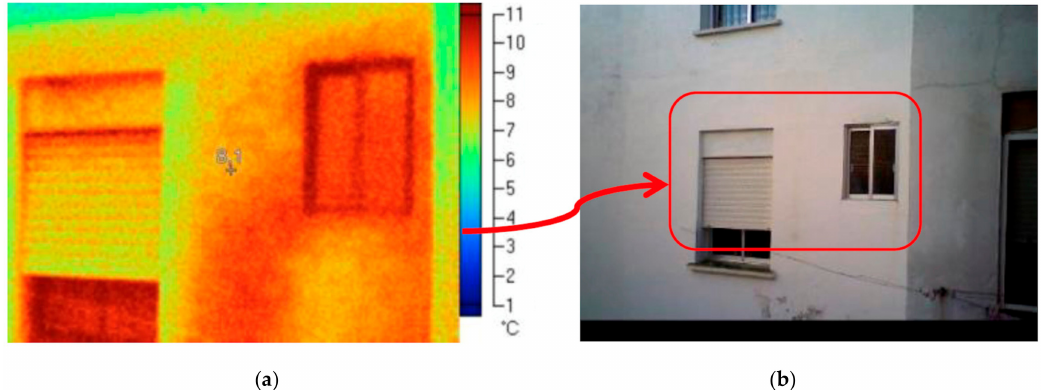
Figure 8. ( a ) Thermal behavior of the dwelling façade that overlooks the backyard; ( b ) Visual